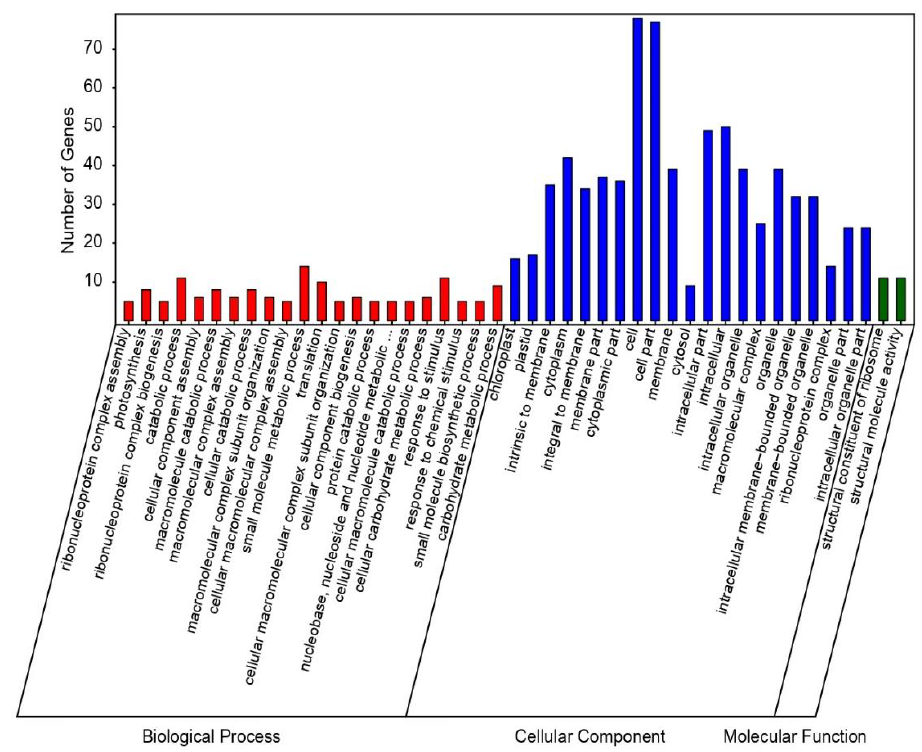
Figure 5. Gene ontology (GO) pathways of up-regulated proteins of WT and mutant line GN-5.